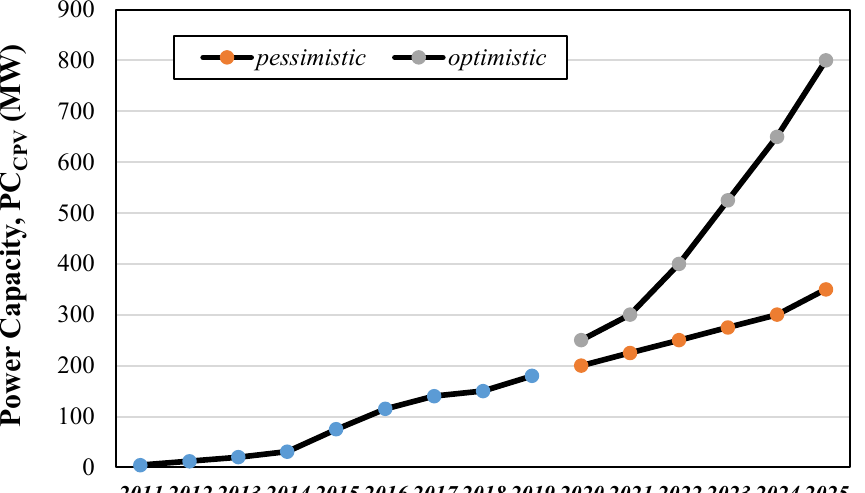
Figure 2. Increase of PC CPV during the years 2013–2019 in two possible forecasts, i.e., optimistic and pessimistic scenarios, for the years 2020–2025.